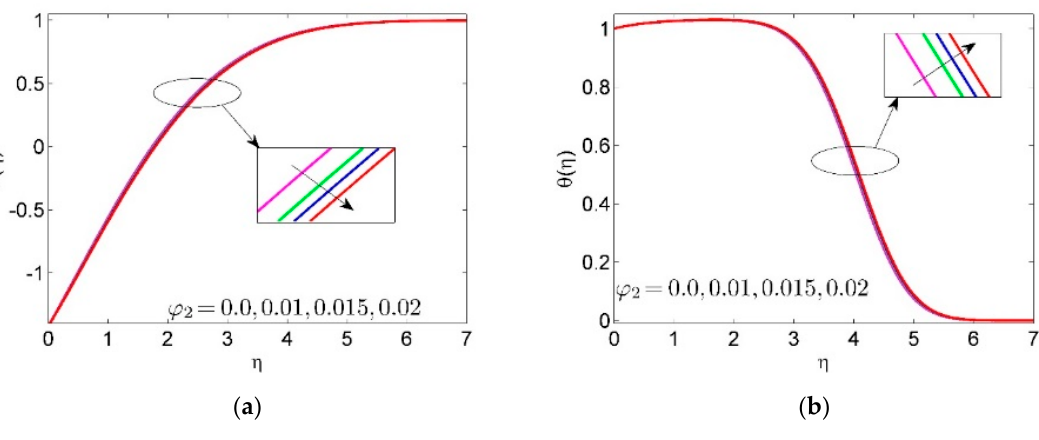
Figure 7. Impacts of 𝜑 (cid:2870) on 𝑓 ′ (𝜂) and 𝜃(𝜂) . Figure 8a,b, display the increasing nanoparticle volume fraction of 𝜑 (cid:2869) and 𝜑 (cid:2870) up to 2% versus Stefan blowing and shrinking state, the skin friction coefficient upsurges. In general, nanoparticle volume fractions produce less resistance at the cylinder surface due to the random motion of HNF/nanoparticles.